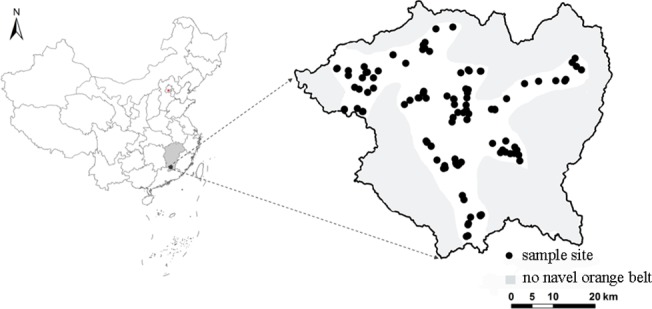
The locations of the soil sampling sites in Xinfeng County.